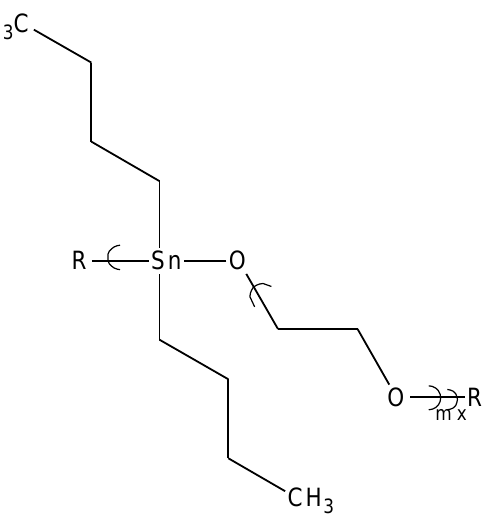
Figure 2. Repeat unit for the product of poly(ethylene glycol) and dibutyltin